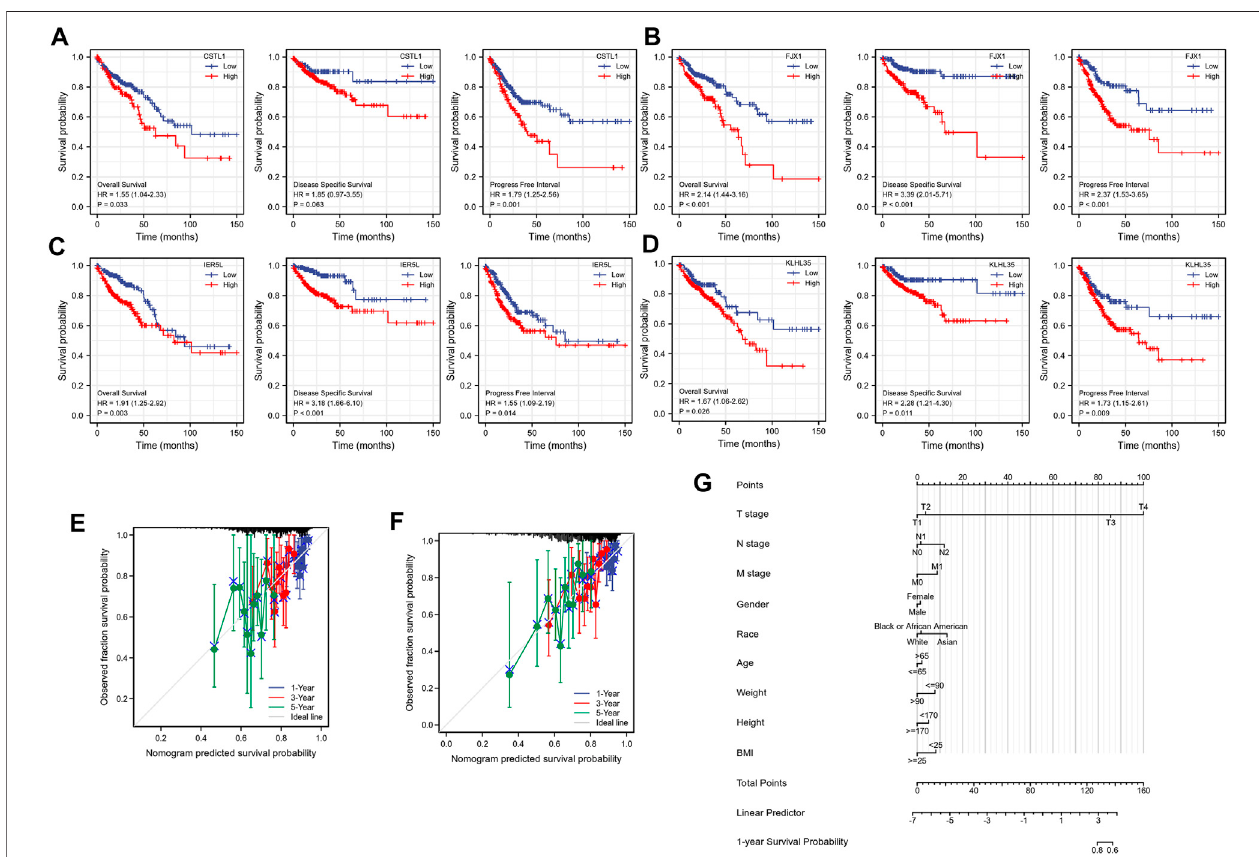
FIGURE 4 | Prognostic correlation analysis. (A – D) Survival analysis of CSTL1, FJX1, IER5L, and KLHL35. (E) Calibration curve of IER5L and KLHL35. (F) Calibration curve of CSTL1 and FJX1. (G) A nomogram based on the prognostic model.